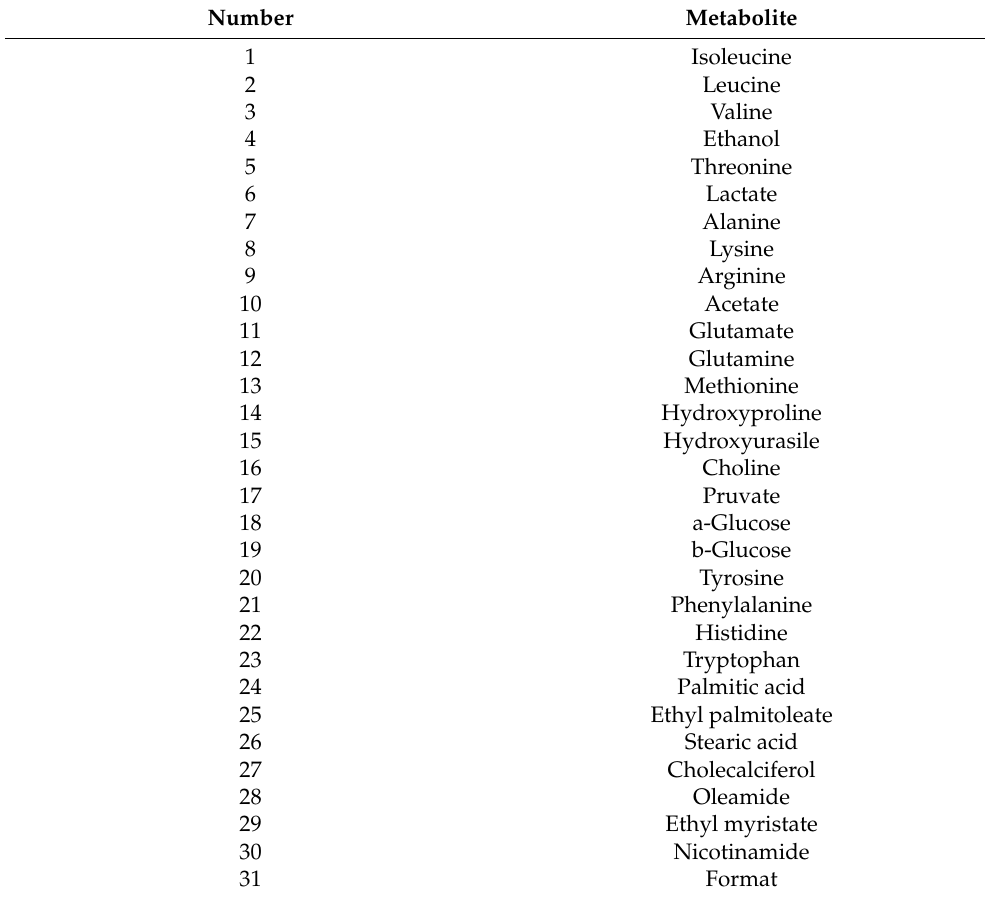
Table 1. Primary metabolites present in bovine umbilical mesenchymal stem cells CM generated by LC-MS and